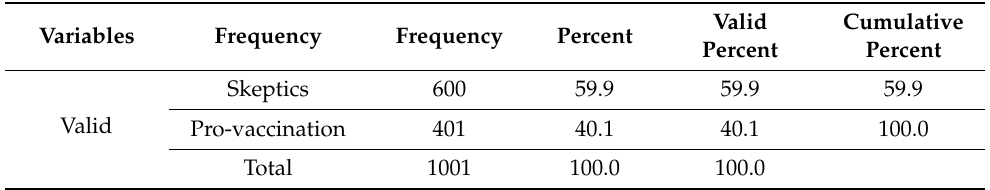
Table 2. The respondents’ attitude towards COVID-19 vaccination.